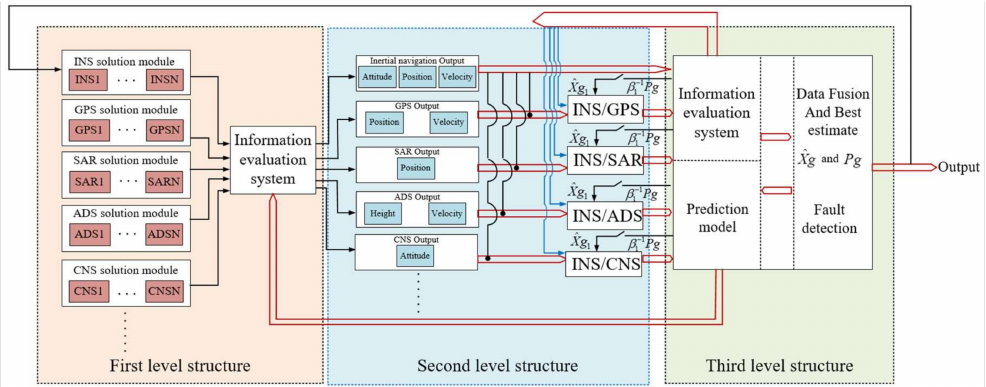
Figure 2. Architecture diagram of resilient multi-source integrated navigation system for aerospace